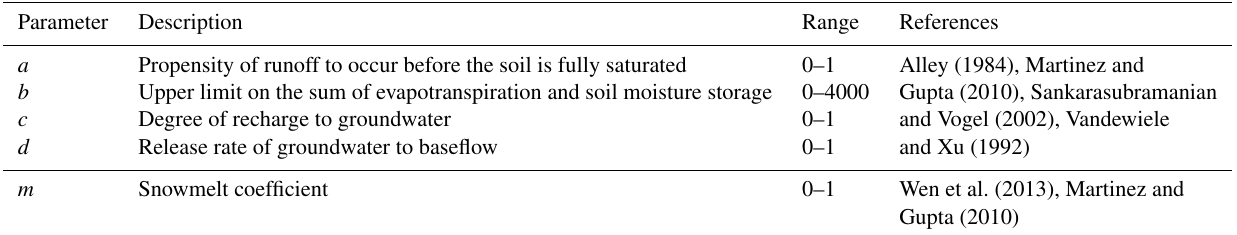
Table 1. Parameter description and ranges for the abcd model (the parameters a , c , d and m are dimensionless, and the unit for parameter b is